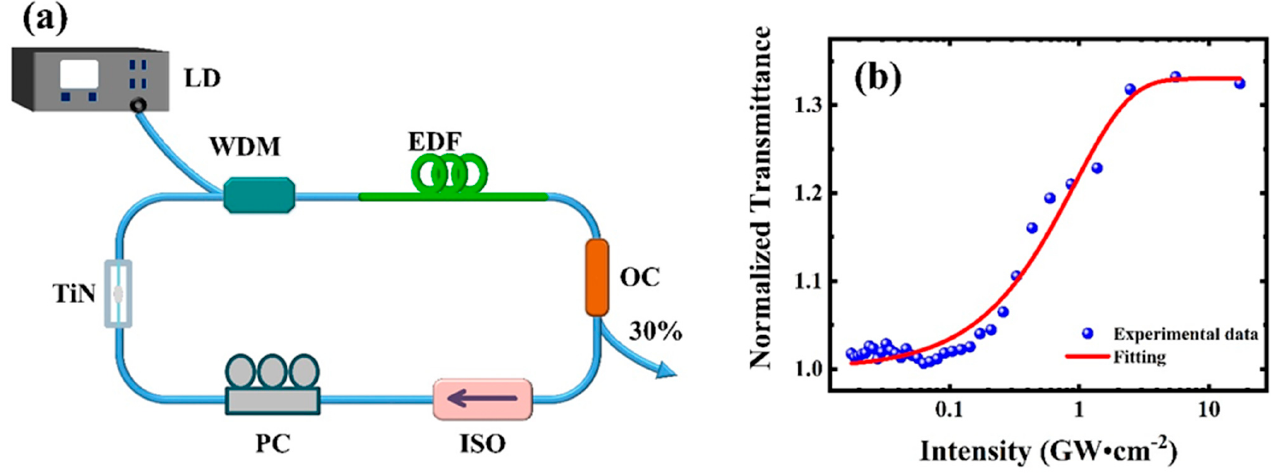
Figure 3. ( a ) Experimental diagram. ( b ) Nonlinear absorption transmission curve of TiN ‐ QD SA.